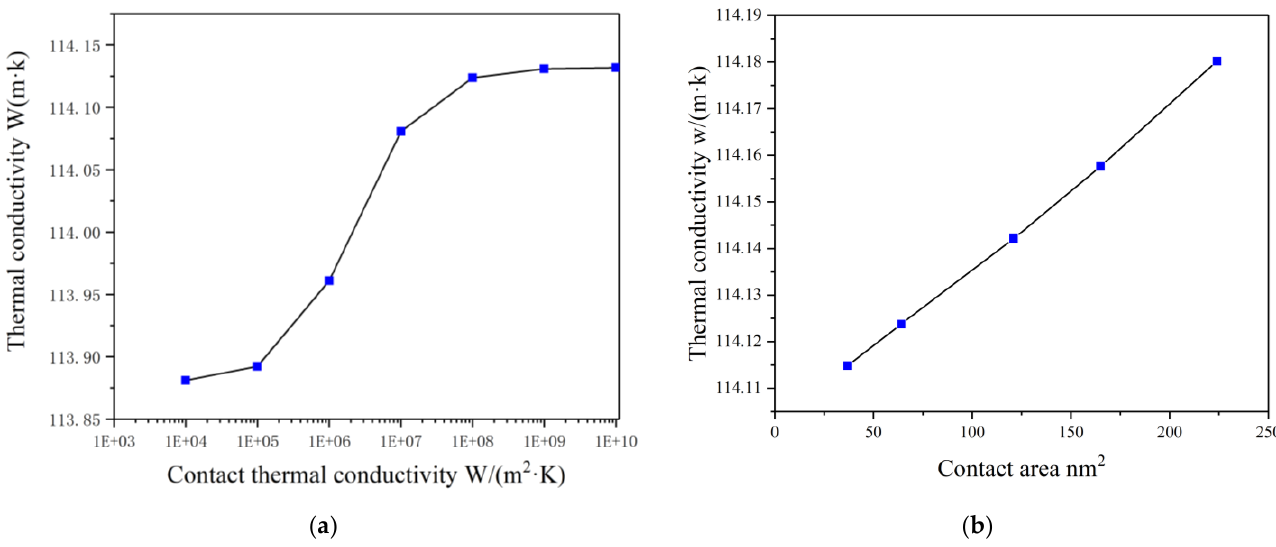
Figure 13. Impact of different influencing factors on K c ( a ) The K c values of models of different C G-C values; ( b ) The K c values of different contact areas between graphene and carbon nanotubes.